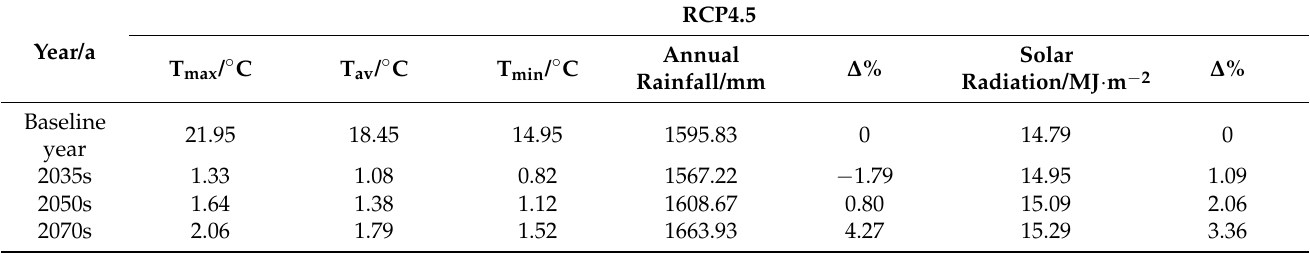
Table 4. Future Changes of Temperature, Rainfall, and Solar Radiation in Nanchang.